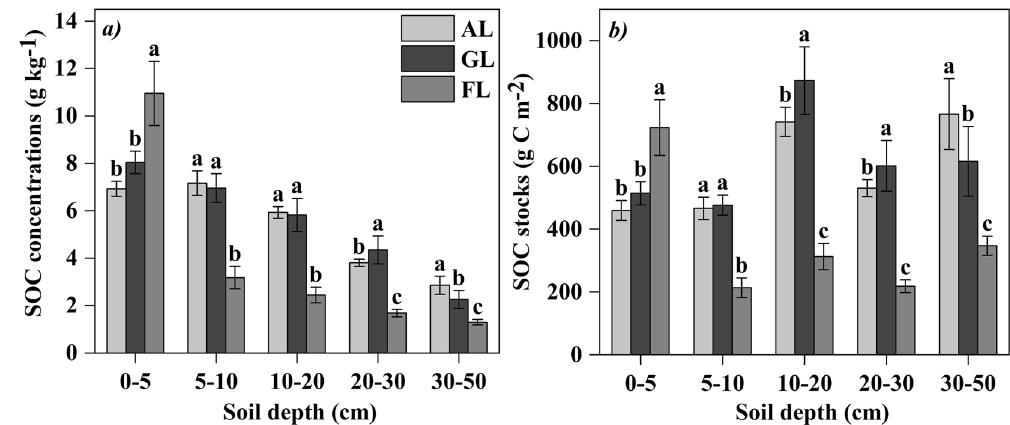
Figure 2. ( a ) Soil organic carbon (SOC) concentration and ( b ) SOC stock (mean ± SD) with different land uses. Different letters at the same soil depth indicate significant difference (n = 5, p < 0.05) among different land uses by one-way ANOVA.